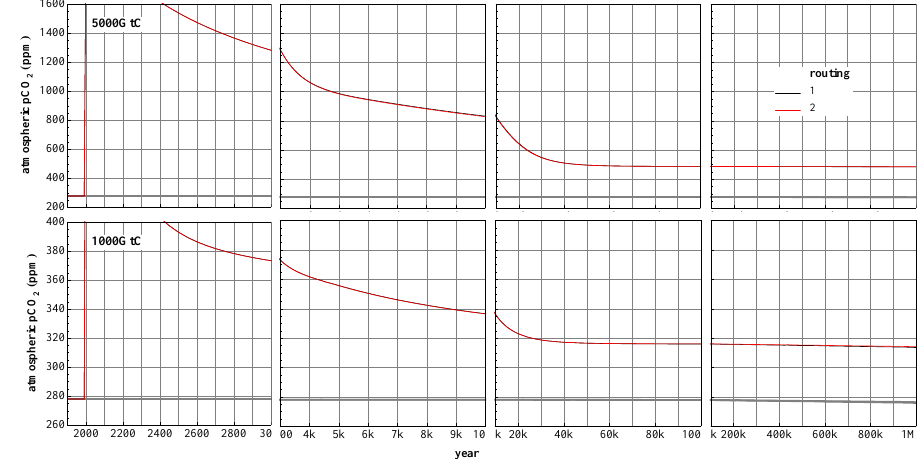
Fig. 15. Evolution of atmospheric CO 2 over 1Myr for 1000GtC (bottom) and 5000GtC (top) emissions pulses, vs. a control run with no emissions (grey lines), for different river routing schemes; schemes 1 and 2 (roof and STN/roof – see text for details) overlap.